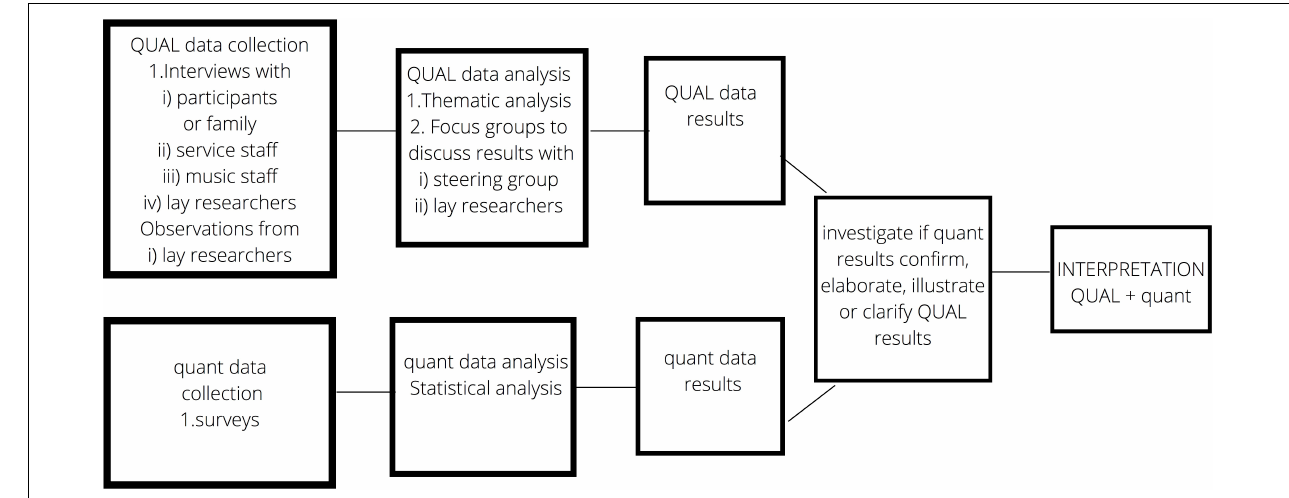
FIGURE 1 | Mixed methods